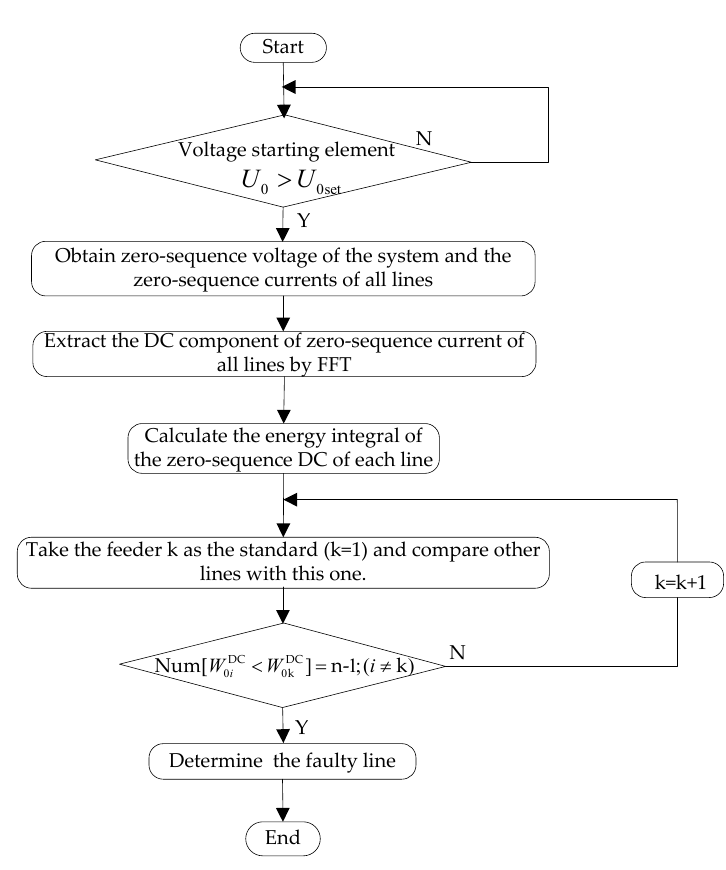
Figure 4. The faulty line identification flow chart.